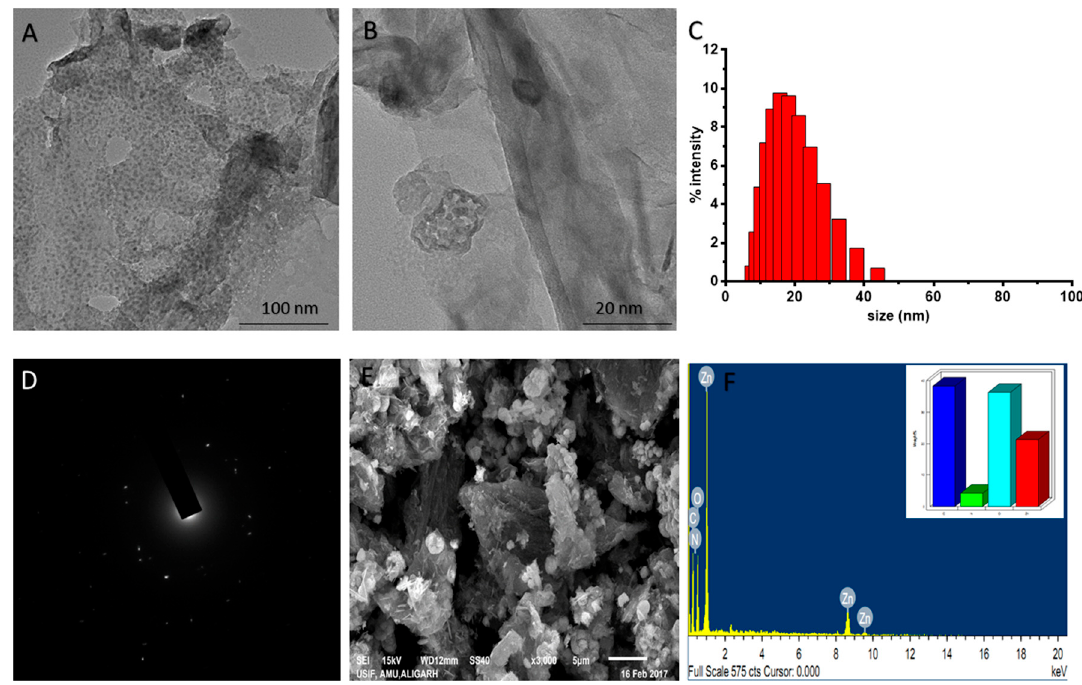
Figure 3. Electron microscopic analysis of as-synthesized GrZnO-NCs. ( A , B ). T.E.M. micrograph and ( C ) Size distribution of the synthesized N.C.s ( D ) S.A.E.D. pattern of GrZnO- N.C.s ( E ) S.E.M. micrograph and ( F ) EDX-spectrum representing components of the N.C.s (Inset distribution of components).